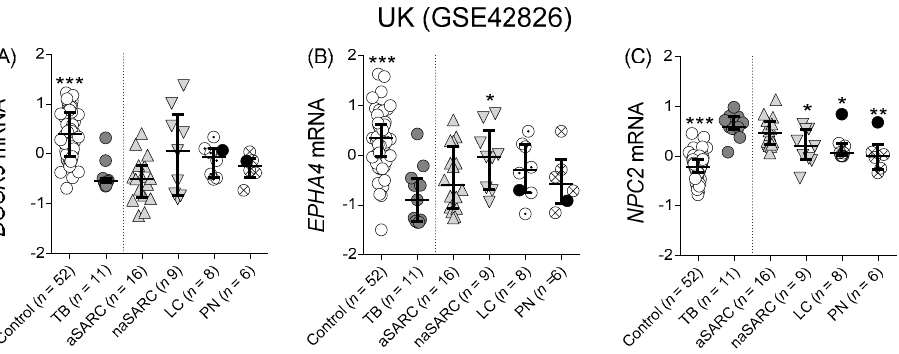
Figure 3. Individual normalized mRNA expression values of ( A ) DOCK9, ( B ) EPHA4, and ( C ) NPC2 mRNA in blood. Diagnostic groups comprise: controls; TB = active tuberculosis; aSARC = active sarcoidosis; naSARC = non-active sarcoidosis; LC = lung cancer; PN = pneumonia. The Kruskal– Wallis test was used to assess significance of differences across more than 2 groups, followed by Dunn’s multiple comparison tests correction. * p -value < 0.05; ** p -value < 0.01; *** p -value < 0.005 with respect to TB. ● single LC and PN patients presenting an NPC2 high profile. UK = United King- dom.